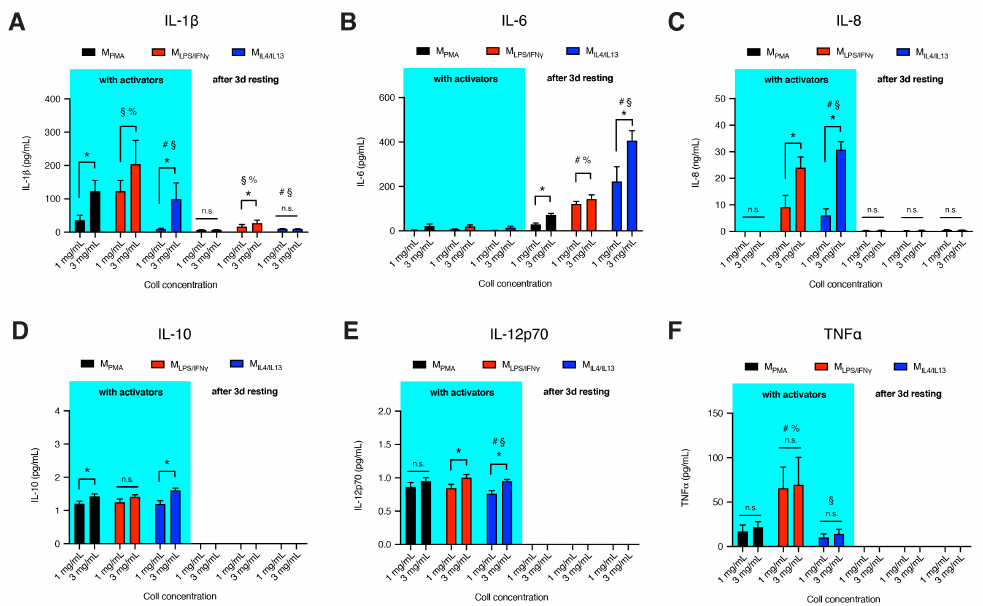
Figure 3. Cytokine secretion by THP-1-derived macrophages in the presence of activators and 3 days after removal of activators. Cytokine secretion ( A ) IL-1 β , ( B ) IL-6, ( C ) IL-8, ( D ) IL-10, ( E ) IL-12p70 and ( F ) TNF α . The experiments were performed at least in 4 replicates. Data are represented as mean ± SD; * significance level of p < 0.05. The characters #, §, % represent the significance level of p < 0.05 when compared to M PMA , M LPS / IFN γ , and M IL-4 / IL-13 macrophages, respectively. Overall, we demonstrated that cytokines released from THP-1-derived macrophages in 3D cell culture are fibril density-dependent. The cytokine secretion pattern from macrophage phenotypes is